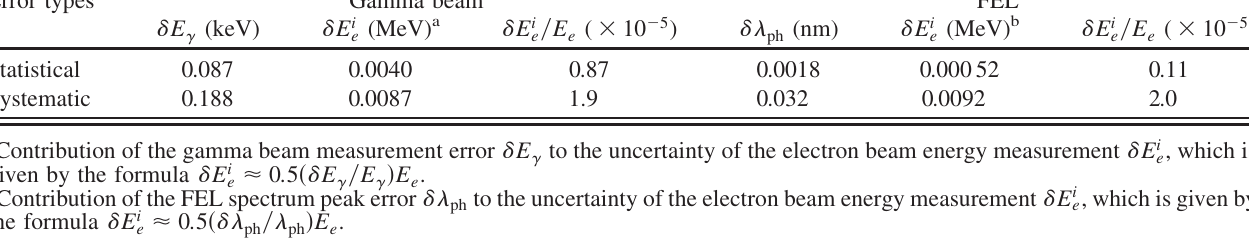
p ffiffiffiffiffiffiffiffiffiffiffiffiffiffiffiffiffiffiffi ¼ 0 : 013 MeV . Clearly, the (cid:4) ð (cid:11)E i Þ 2 i e